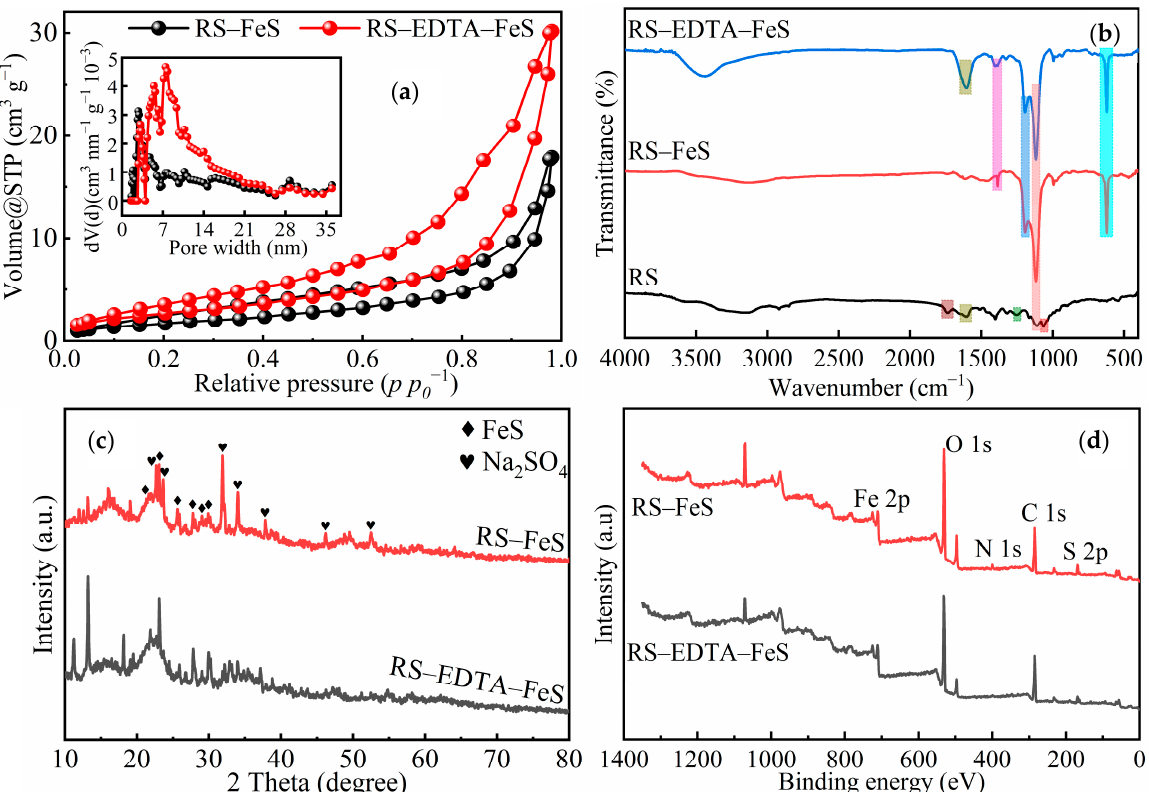
Figure 2. Nitrogen adsorption–desorption isotherms ( a ), FTIR spectra ( b ), XRD pattern ( c ), and XPS wide scan spectra analysis ( d ) of RS–FeS and RS–EDTA–FeS.